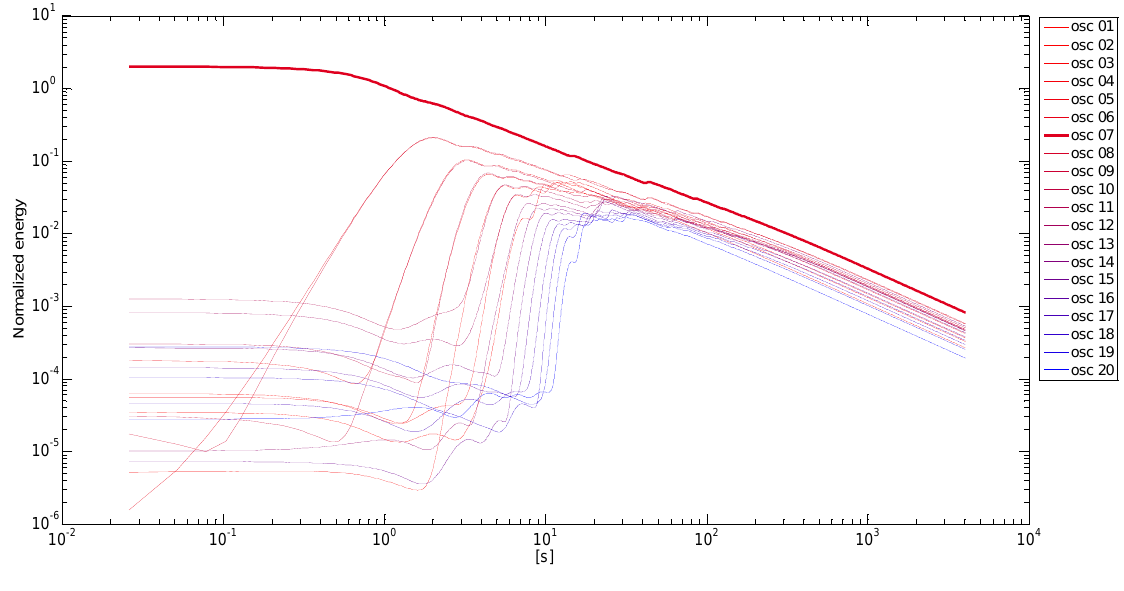
Fig. 12. Uniform chain with proportional damping, time energy averages versus time, x, y axes in log scale.